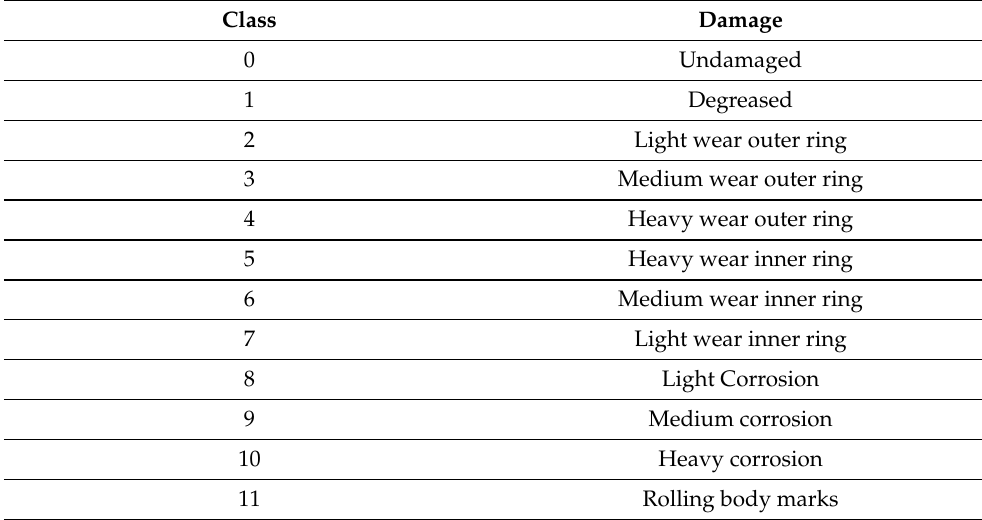
Figure 1. Ball bearing with heavy corrosion. Table 1. Classes of